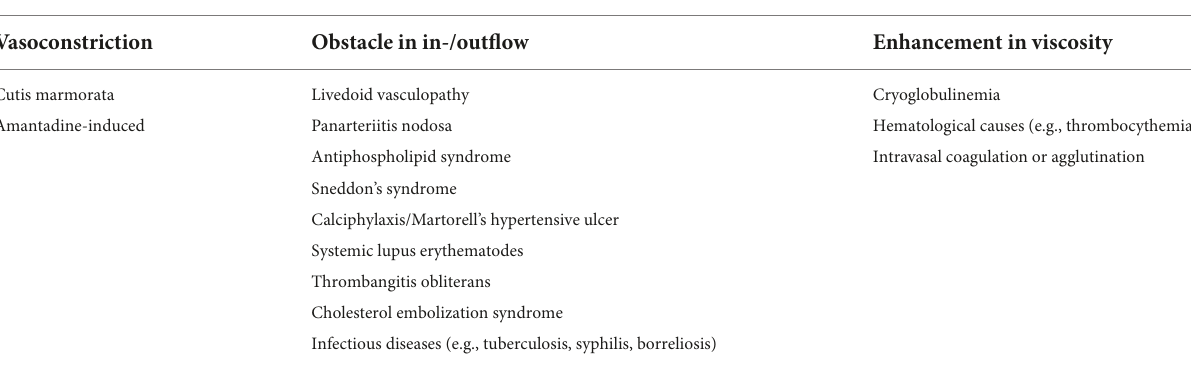
TABLE 1 Diseases associated with Livedo reticularis and Livedo racemosa (selection). Livedo